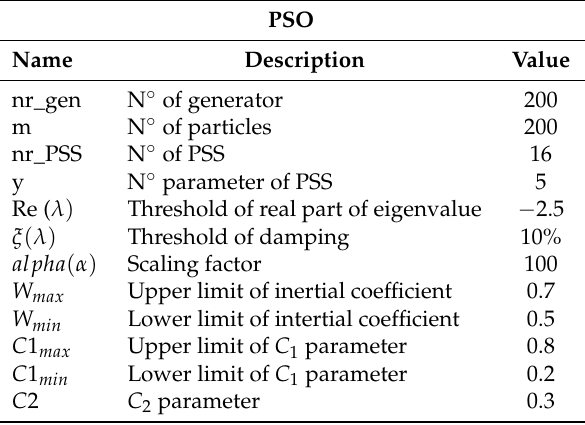
Table 7. Variables of PSS for system